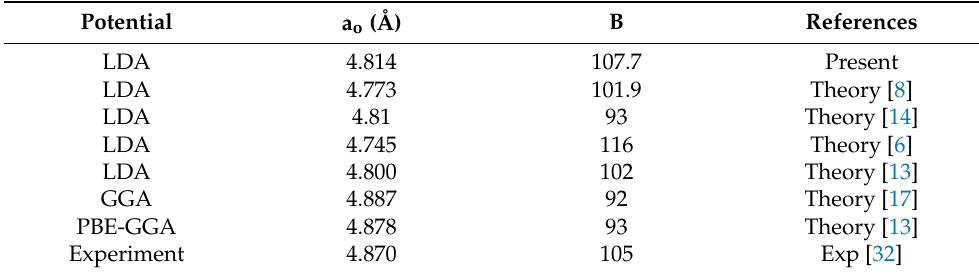
Figure 4. The total energy versus the lattice constant for zb-BeS. Table 5. Calculated lattice constant (a o ) and bulk modulus (B) utilizing the LDA potential compared to the experiment and other theoretical